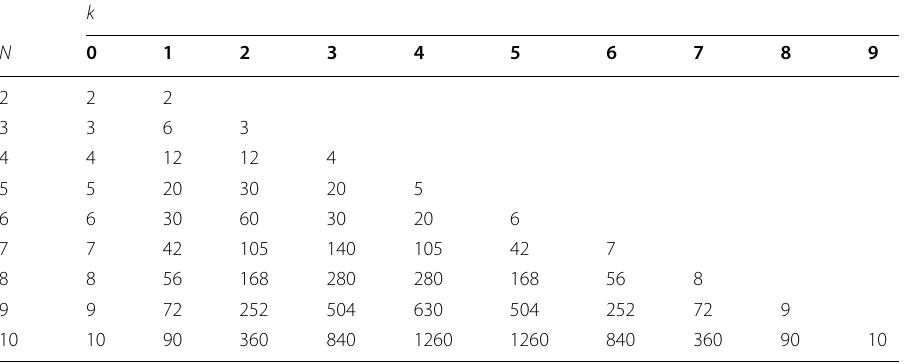
Table 1 Denominator of the coefficients (weights) in the decomposition